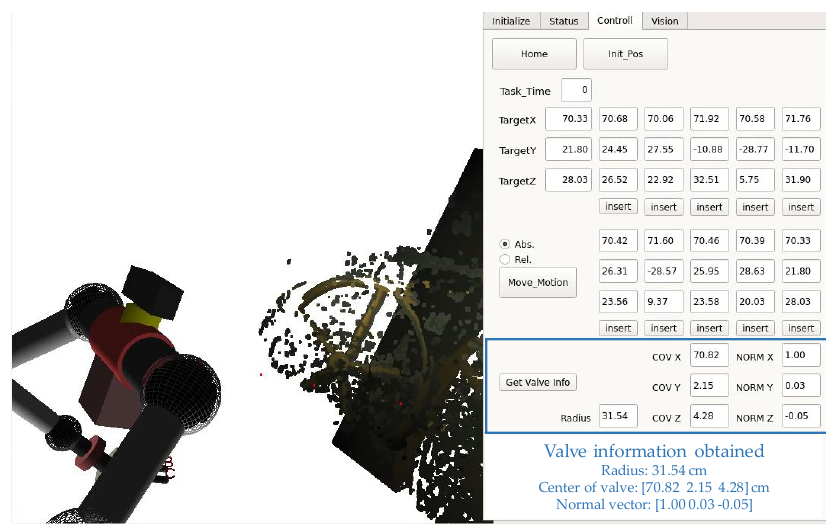
Figure 12. The obtained valve information.